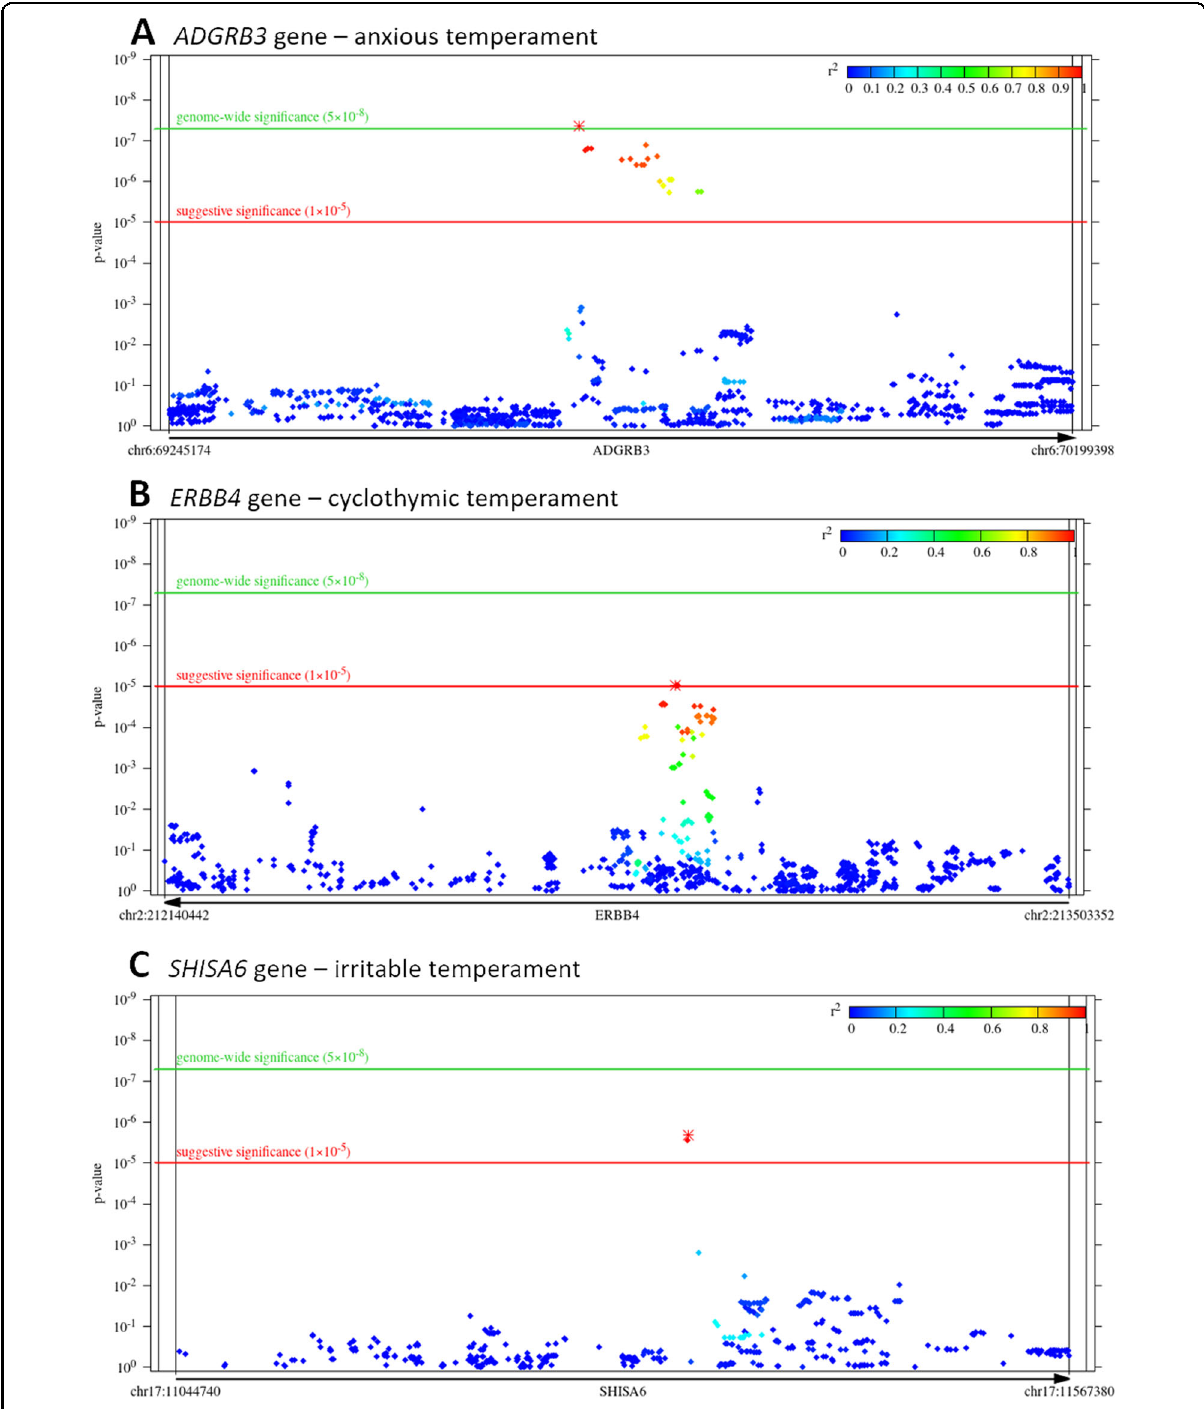
Fig. 1 Zoomed Manhattan plots of signi fi cant or suggestively signi fi cant SNPs for anxious, cyclothymic and irritable temperaments. Zoomed Manhattan plots of A ADGRB3 gene on chromosome 6 for anxious temperament as the outcome phenotype ( rs3798978 survived correction for genome-wide signi fi cance ( p = 4.44 × 10 − 8 ), whereas 21 other SNPs showed suggestive signi fi cance); B ERBB4 gene on chromosome 2 for cyclothymic temperament as the outcome phenotype (4 SNPs showed suggestive signi fi cance); and C SHISA6 gene on chromosome 17 for irritable temperament as the outcome phenotype (2 SNPs showed suggestive signi fi cance). P -value is displayed in function of genomic position for each single-nucleotide polymorphism (SNP) in the region. Colours denote the r 2 -value of linkage disequilibrium (LD) with the most signi fi cant SNP (marked with asterisk). Gene boundaries and their extension by 10,000 base pairs (as de fi ned for the gene-based tests) are marked with vertical